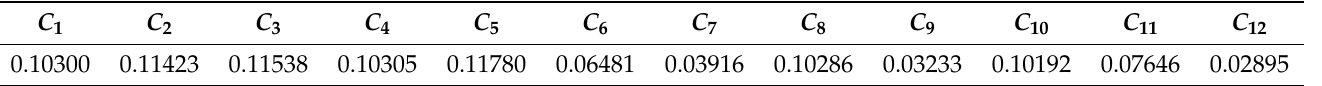
Table 12. Criteria weights determined for the whole set of alternatives using the CRITIC